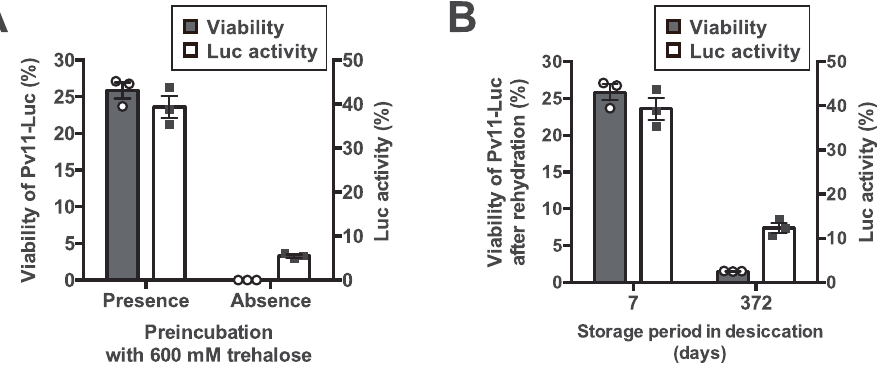
Figure 3. Effect of storage periods on Pv11-Luc cell survival after desiccation. Viability of dry-preserved Pv11- Luc cells (bars in grey) and the corresponding relative Luc activity (bars in white) after rehydration are shown as a scatter dot plot (n = 3). Error bar shows standard error of mean. ( A ) Effect of the preincubation with trehalose on cell viability and Luc activity. Desiccated Pv11-Luc cells that did or did not undergo trehalose pre-incubation were kept in a desiccator for 7 days. Cell viability and Luc activity were examined after rehydration, and are shown as a scatter dot plot. Error bar shows standard error of mean (n = 3). ( B ) The long-term preservation of desiccated Pv11-Luc cells with trehalose pretreatment. Desiccated Pv11-Luc cells were kept for 7 and 372 days in a desiccator.